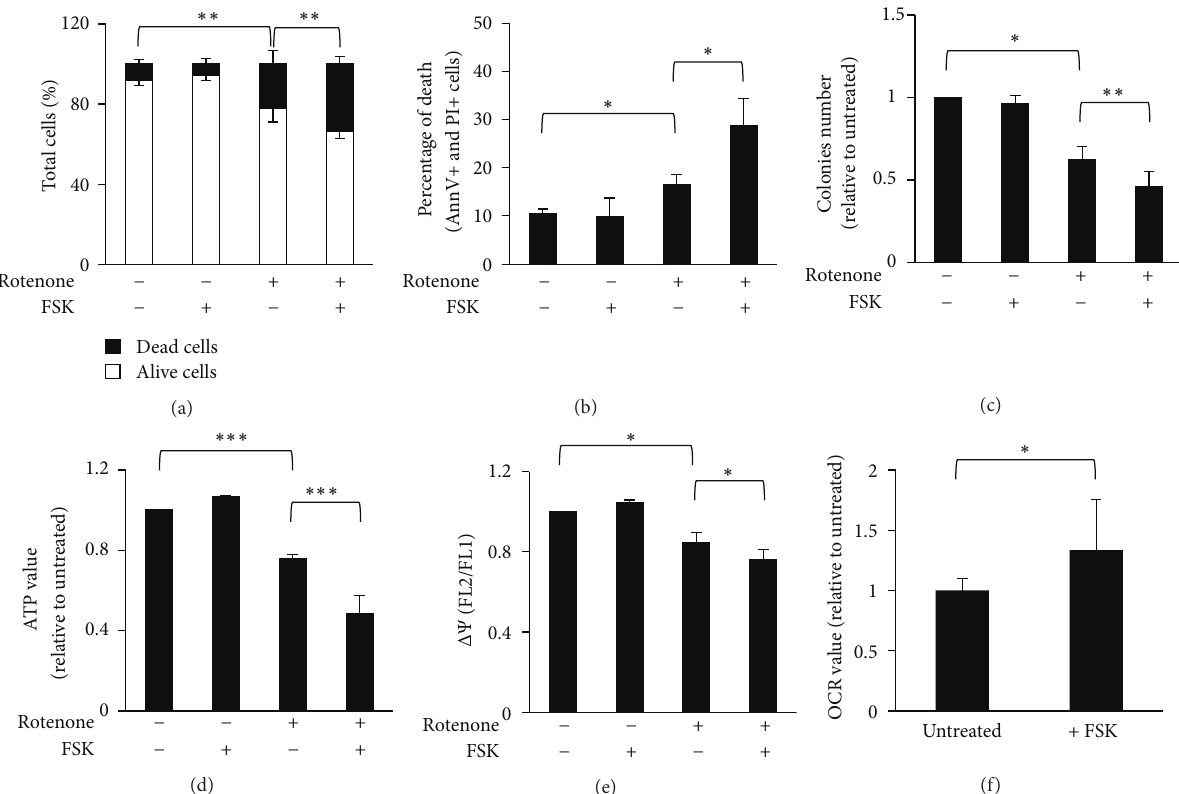
Figure 3: FSK treatment enhances the viability loss induced by rotenone alone in MDA-MB-231 cells. MDA-MB-231 cells were cultured in 1mM glucose and treated with 3nM rotenone, 10 𝜇 M FSK, or both molecules at 48 hours of culture. Cells were pretreated for 1 hour with FSK and then rotenone was also added for 4 hours, as shown in Figure 2(c). After treatment different parameters were investigated in untreated (−) and treated (+) cells. Viable cell count was performed using Trypan Blue (a). Percentage of cell death was evaluated after staining with PI and Annexin V-FITC (AnnV). Cells positive for one or both molecules were considered dead cells (b). After treatment 3 × 10 3 cells were plated in normal growth medium for clonogenic assay and after ≥ 12 days colonies were stained and counted as reported in the histogram (c). (d) Intracellular ATP levels and (e) mitochondrial potential were also measured. All data represent the average of at least three independent experiments ( ± s.d.); ∗ 𝑃 < 0.05 , ∗∗ 𝑃 < 0.01 , ∗∗∗ 𝑃 < 0.001 (Student’s 𝑡 -test). (f) Basal OCR of MDA-MB-231 cells, grown 1mM glucose and treated or not with FSK for 2–4 hours, was determined by Seahorse XF24 analyzer. Analysis was performed in three independent experiments (total number of samples ≥ 15) and values are indicated as the average ± s.e.m.; ∗ 𝑃 < 0.05 (Student’s 𝑡